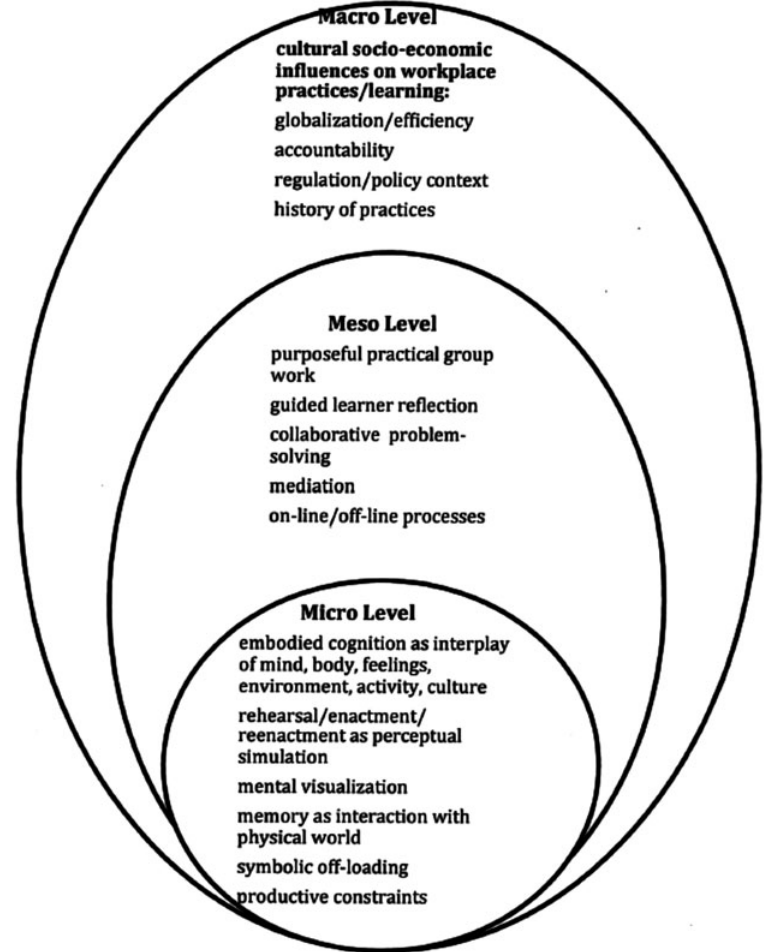
Figure 1: Applied Learning ‘Reciprocal Venn’